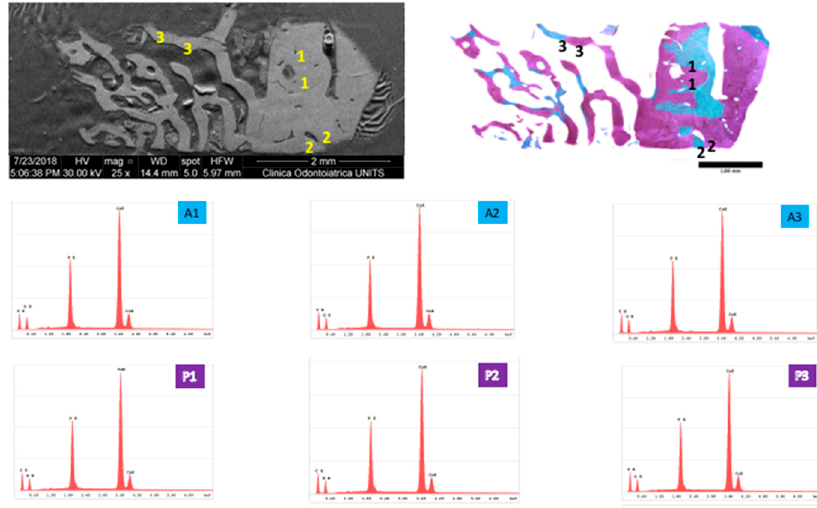
Figure 7. Upper left: detail of secondary electrons SEM image of the bone specimen with the numerical identification of the sites selected for EDX analysis; upper right: histological section stained with acid fuchsine-toluidine blue modified according to histomorphometric results to highlight NFB (Azure) and RG (purple) with correspondence of numerical reference for EDX examination; A1, A2, A3: EDX analysis for NFB; P1, P2, P3: EDX analysis for RG. SEM, scanning electron microscope; EDX, Energy Dispersive X-ray; NFB, newly-formed bone; RG, residual graft.